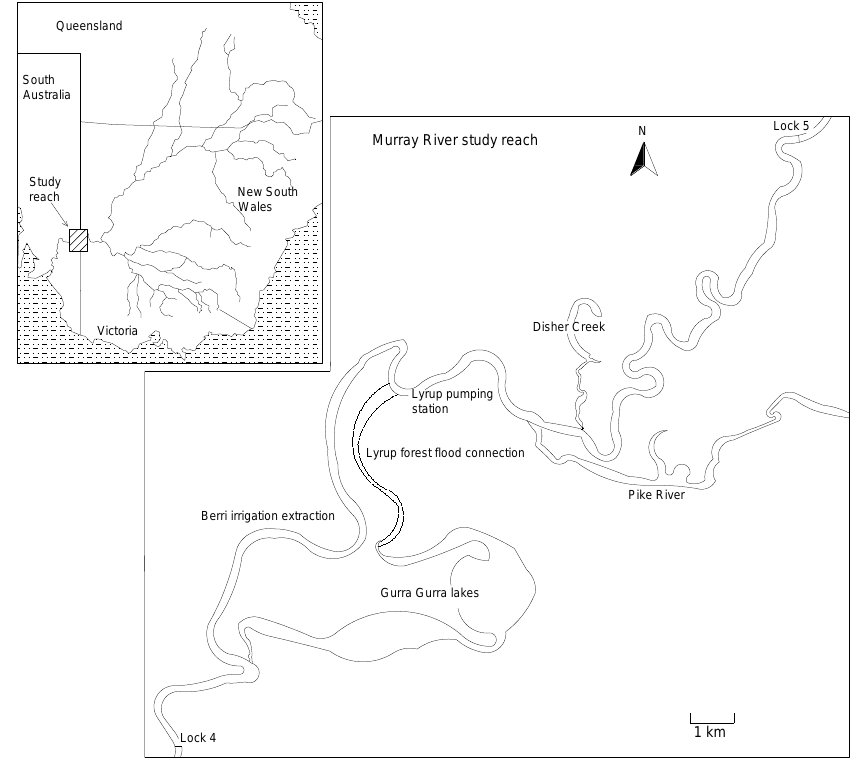
Figure 4. Map of case study